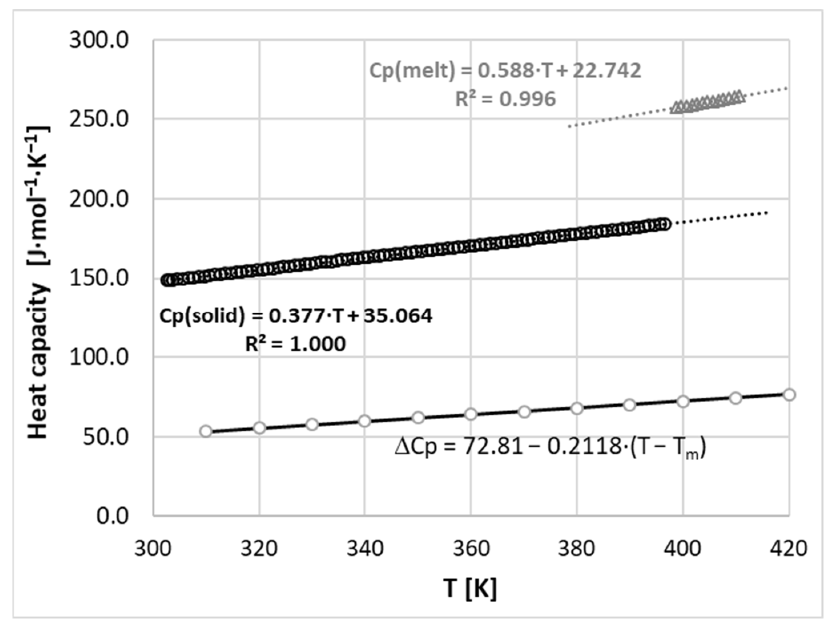
Figure 1. Measured temperature trends of solid and melt states of nicotinamide, where ∆ C fus p ( T ) = 𝐶 (cid:3043) (𝑙)(T) − 𝐶 (cid:3043) (𝑠)(T) stands for the heat capacity difference between a supercooled liquid and solid.